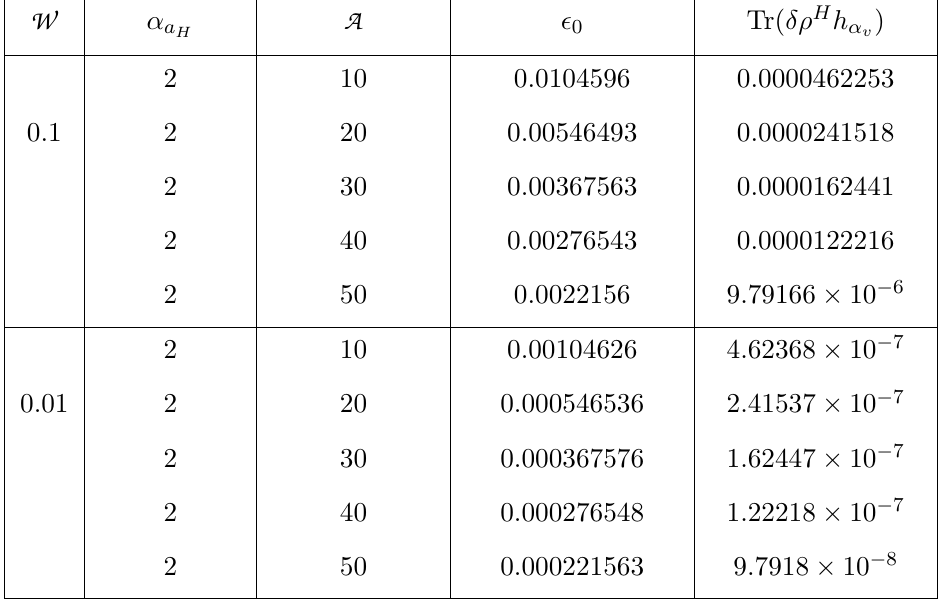
Table 1. The values of (cid:15) 0 and corresponding values of Tr ( δρ H h α